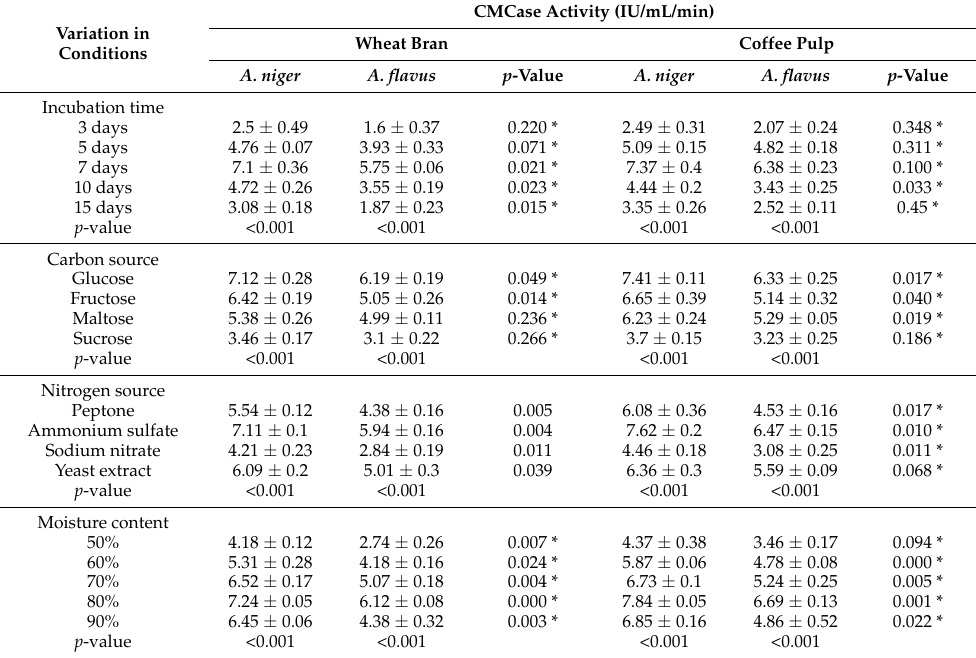
Table 5. Optimization of the incubation period, carbon source, nitrogen source, and moisture content for CMCase production under SSF by A. niger and A. flavus using wheat bran and coffee pulp as a